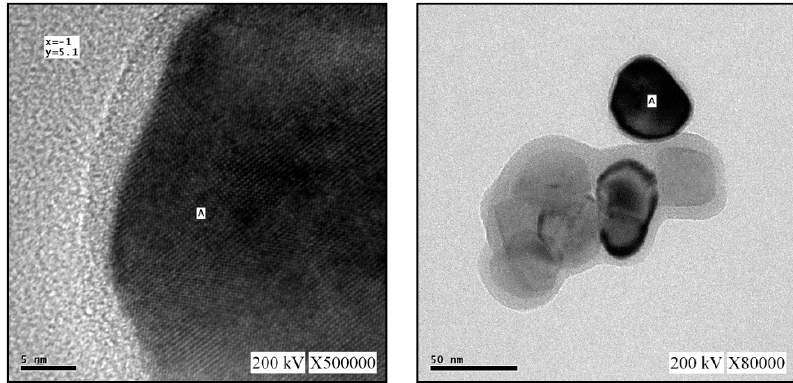
Figure 7. Transmission electron microscopy (TEM) images of core-shell structure in BaTiO 3 -MOD-Y.